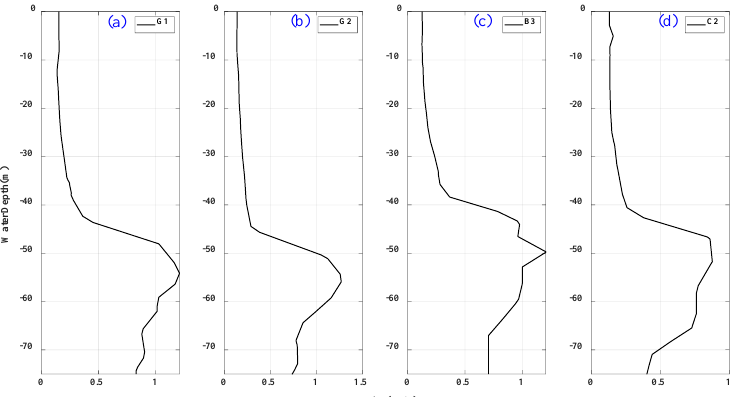
Figure 11. Chlorophyll concentration at G1 , G2 , B3 and C2 , measured in the shipborne experiment using the RBR XR-420. ( a ) chlorophyll concentration at G1 ; ( b ) chlorophyll concentration at G2 ; ( c ) chlorophyll concentration at B3 ; ( d ) chlorophyll concentration at C2 .